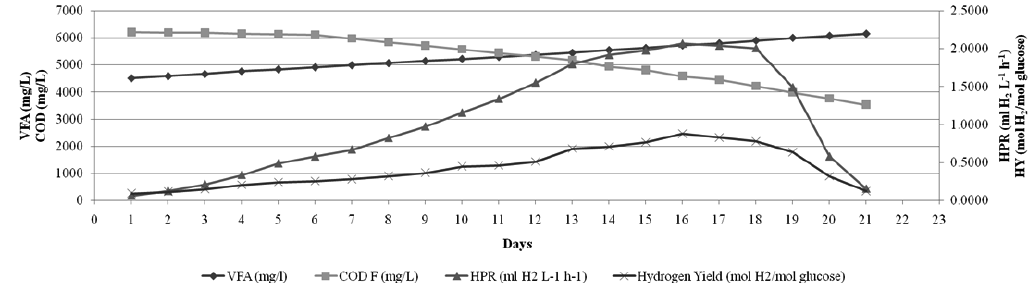
Fig. 3. Fermentation studies on Biohydrogen Production in Food industrial wastewater (90 %) at pH 6.5 using Mixed Isolate (F1 and A3) as